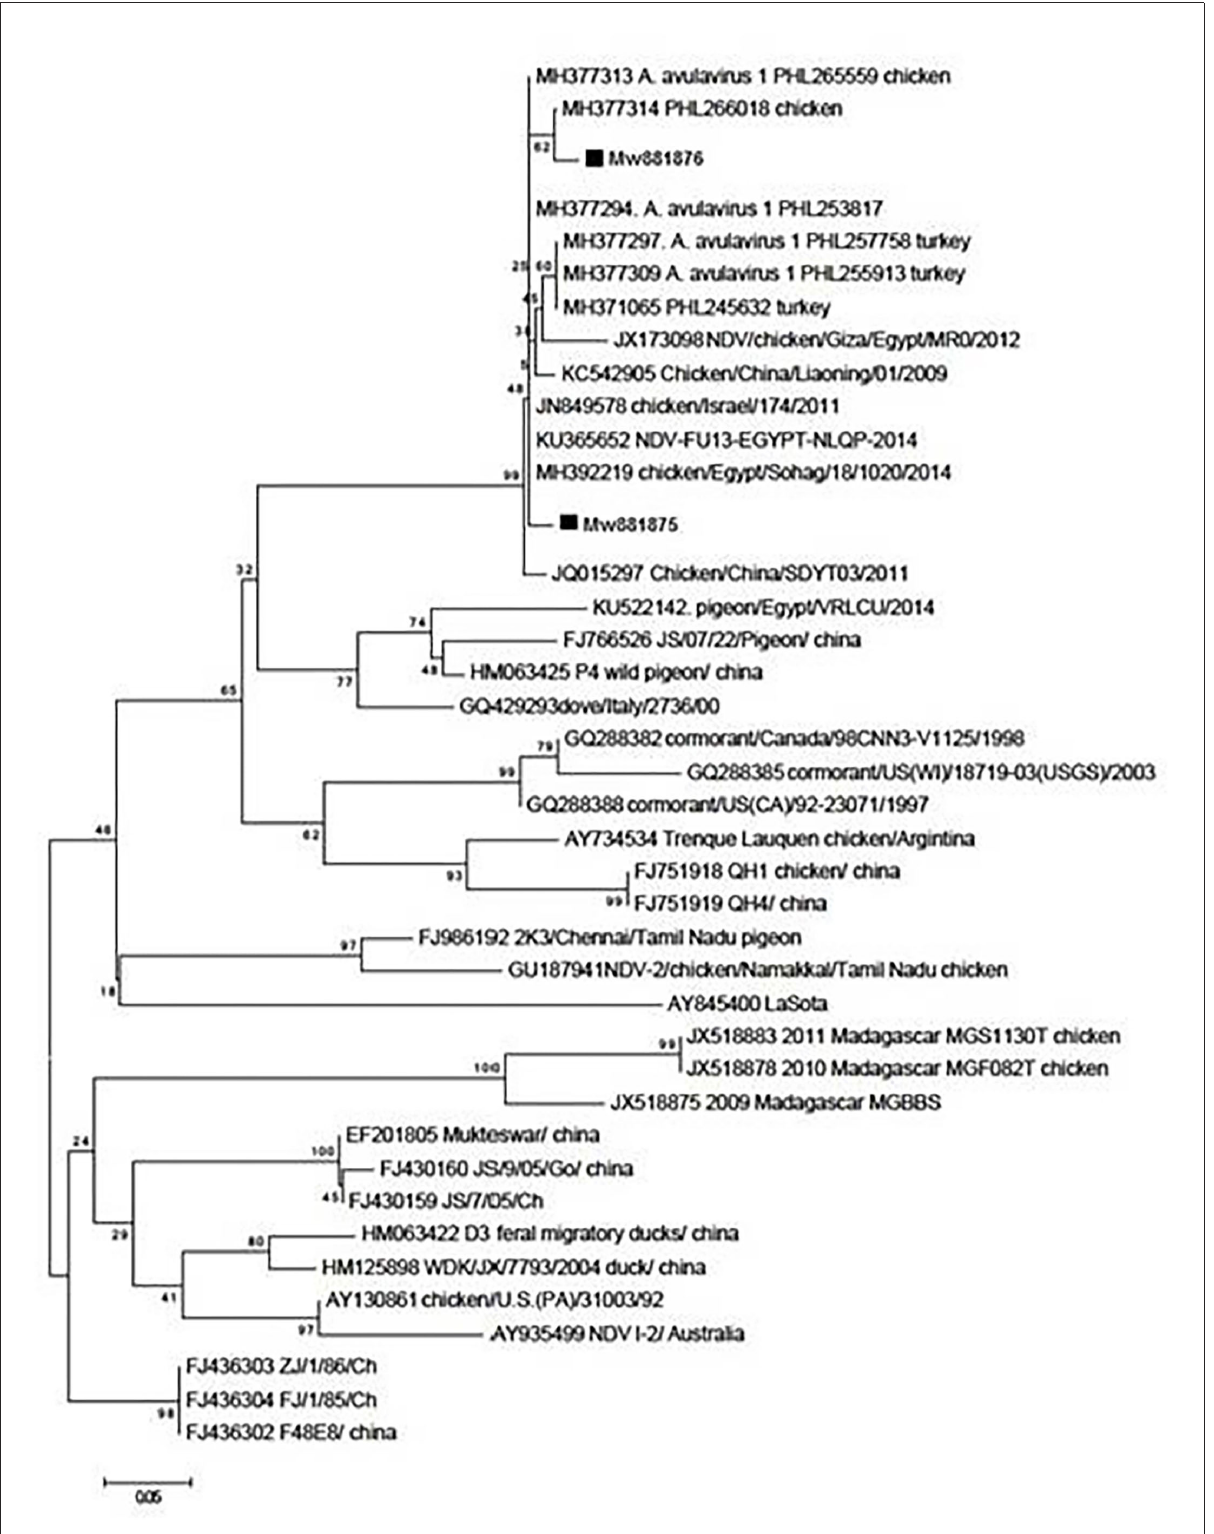
FIGURE1 Phylogenetic analysis of nucleotide sequences of the partial fusion genes F and M from two Egyptian samples with other sequences of the reference strains from GenBank using the neighbor-joining method and 1,000 bootstrap replicates.